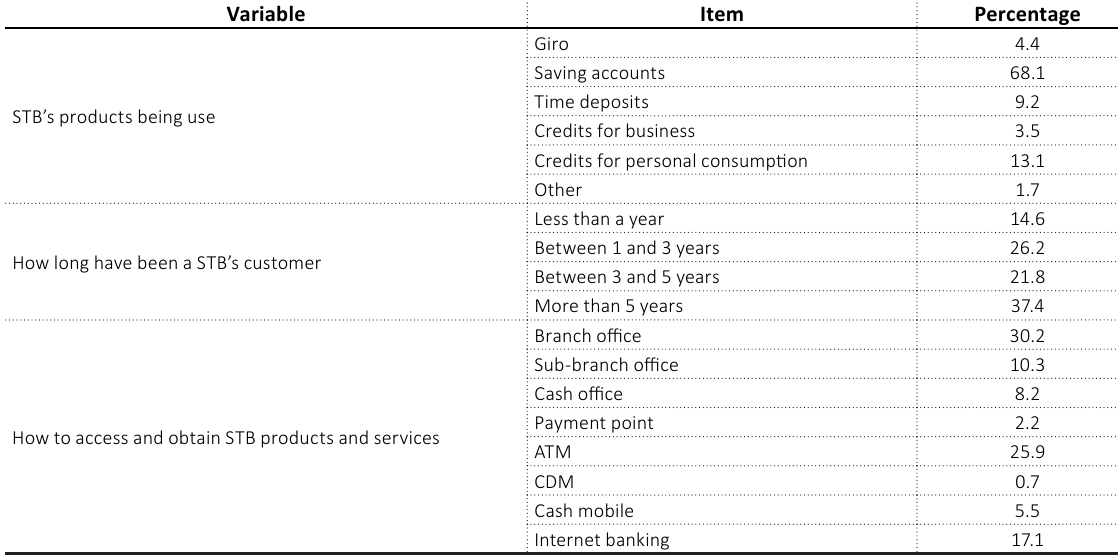
Table 4. Demographic profile of STB customer respondents